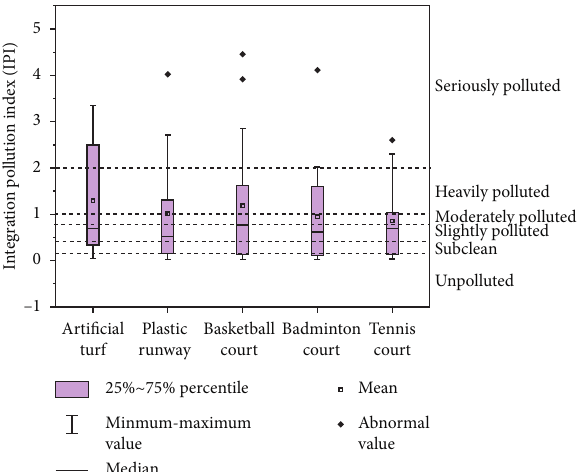
Figure 4: Box-plots for integrated pollution index (IPI) of metals and metalloids in five athletic field runoffs. For reference, dashed lines indicate the different pollution classes by Yan et al. (2015)